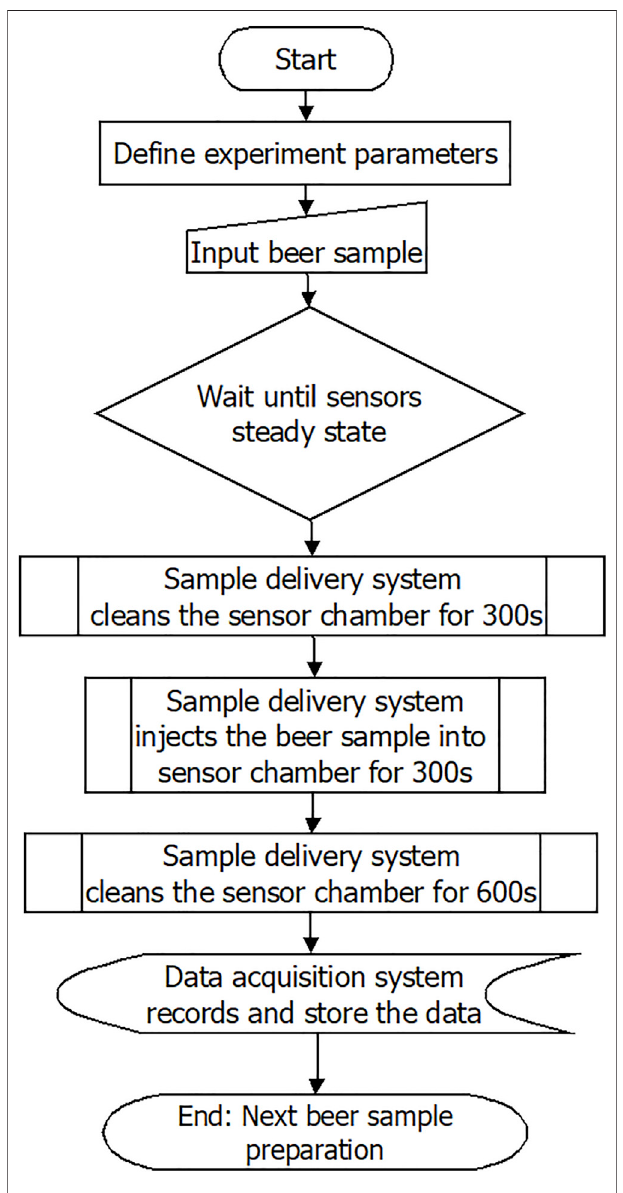
FIGURE 3 | Flowchart of the experiment